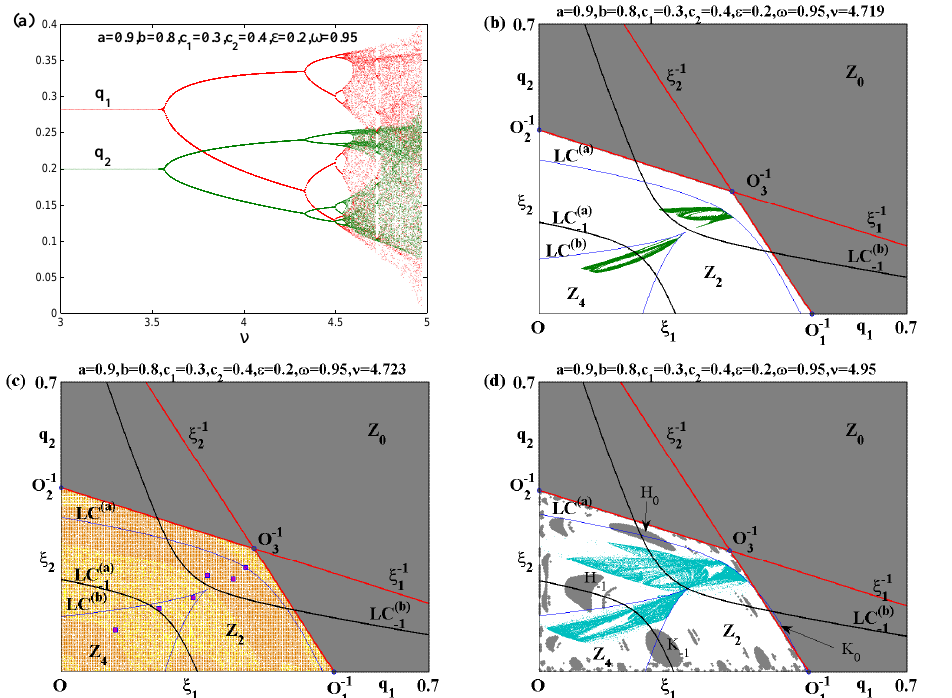
Figure 4. ( a ) A 1D bifurcation diagram with respect to ν at a = 0.9, b = 0.8, c 1 = 0.3, c 2 = 0.4, (cid:101) = 0.2, ω = 0.998. The attractive basin at a = 0.9, b = 0.8, c 1 = 0.3, c 2 = 0.4, (cid:101) = 0.2, ω = 0.998, for ( b ) a two-bands chaotic attractor at ν = 4.719, ( c ) period 6 cycle at ν = 4.723, and ( d ) one piece chaotic attractor at ν =